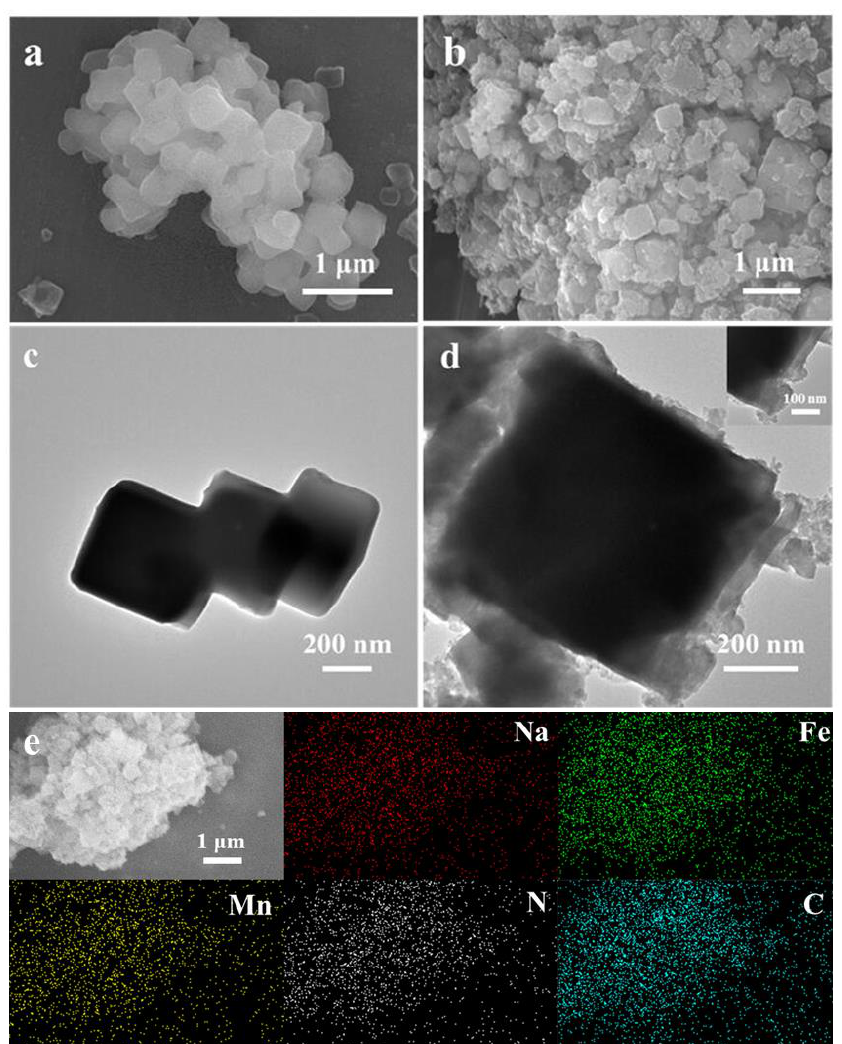
Figure 2. SEM and TEM images of NMHFC ( a , c ) and NMHFC@PPy ( b , d ) and ( e ) EDS-mapping elemental analyses of NMHFC@PPy.